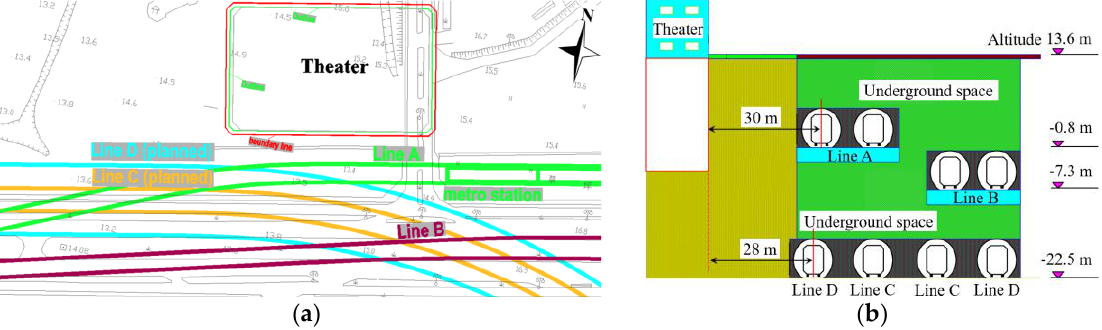
Figure 1. The plane ( a ) and section ( b ) positional relationships of the theater and the metro lines. The shortest horizontal distance between the theater (designed outline) and Metro Line A (middle line of the closed tunnel) is 30 m. To the south of Line A, Line B passes over with the shortest horizontal distance from the theater of around 80 m. The proposed Metro Line C and Line D will pass to the south of the theater with the shortest distance of 28 m, and these two lines are currently in the stage of preliminary design. Based on the principle of preconception, priorities are given to Line A and Line B in the assessment of train-induced vibration and radiated noise. In return, the assessment results can also help provide a reference for the anti-vibration design of Metro Line C and Line D.